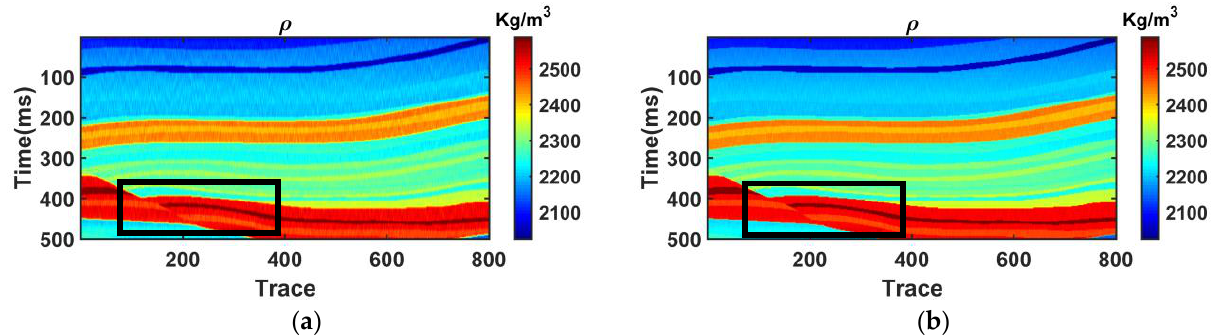
Figure 17. Density inversion results after adding noise based on ( a ) traditional method and ( b ) reweighted Lp method.